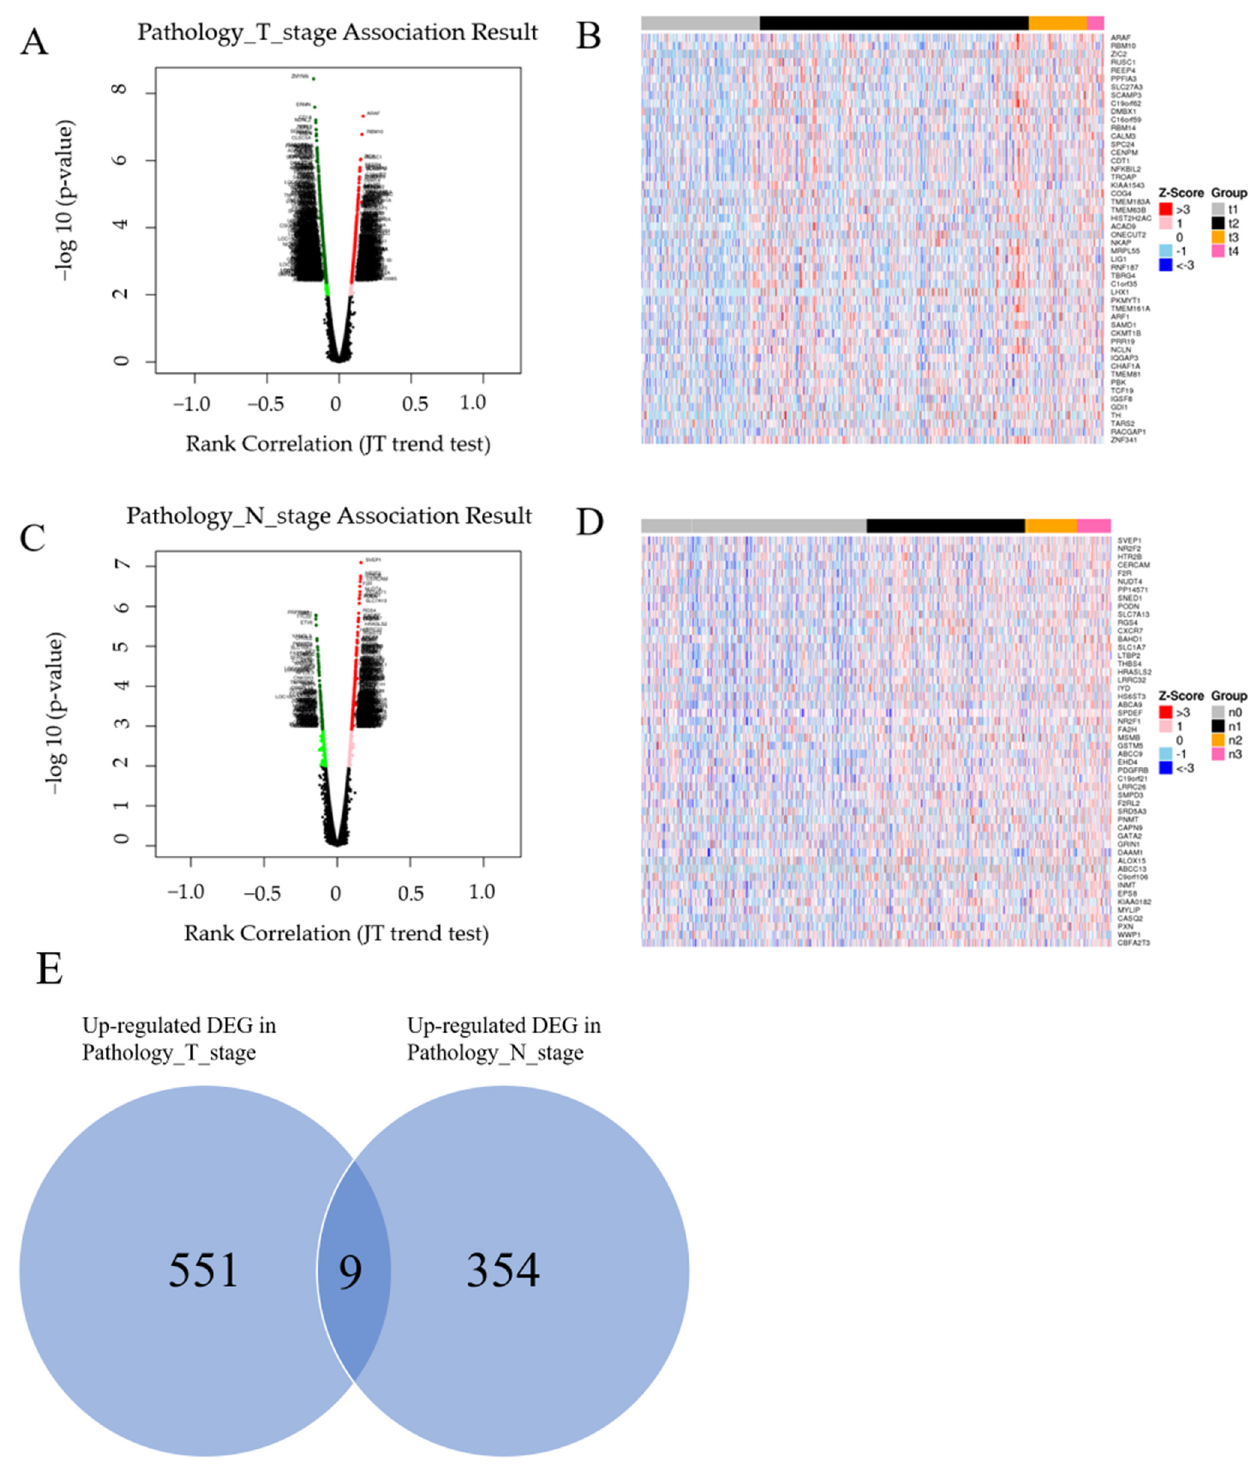
Figure 2. ( A ) LinkedOmics analysis. A volcano map showing genes that are positively and negatively correlated with T factor. ( B ) The heatmap shows the top 50 genes that are positively correlated with T factor. ( C ) The volcano map shows the genes that are positively and negatively correlated with N factor. ( D ) The heatmap shows the top 50 genes that are positively correlated with N factor. ( E ) Overlapping DEGs between the T (551) and N stages (354) are nine.